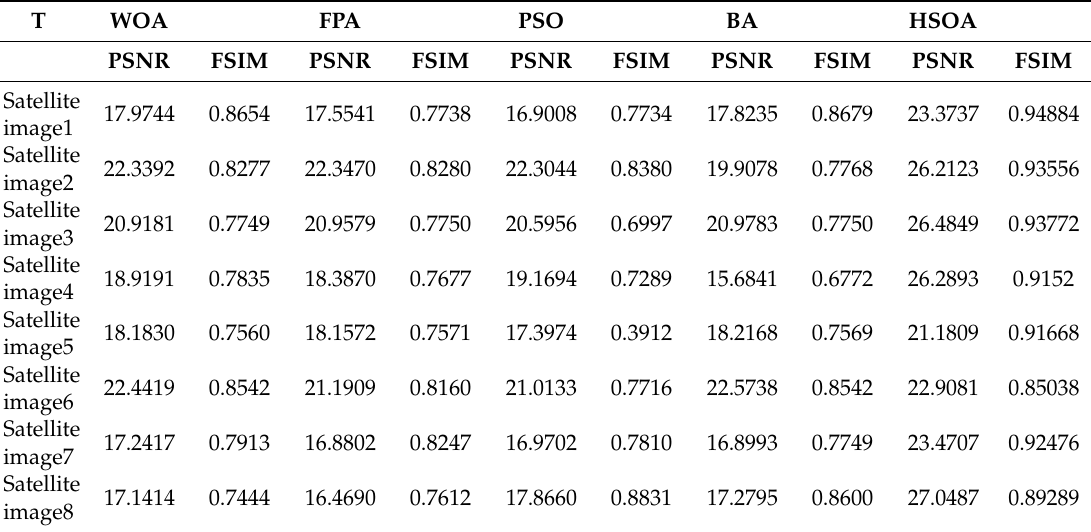
Table 2. The PSNR and FSIM of each algorithm under 3DPCNN.